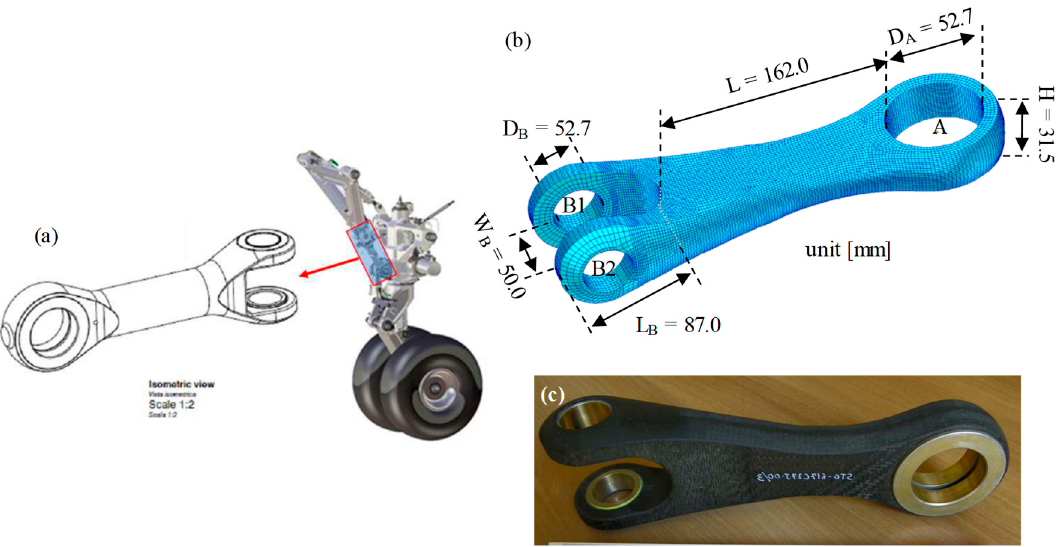
Figure 1. ( a ) Schematic view of the landing gear (LG) and standard drag brace; and ( b ) design and ( c ) picture of the composite drag brace.